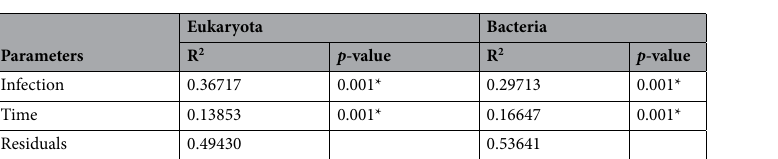
Table 1. Effects of aphelid infection and incubation time on eukaryotic and bacterial protein groups as revealed by PERMANOVA analysis of euclidean distances. Significant differences ( p < 0.05) are indicated by asterisk